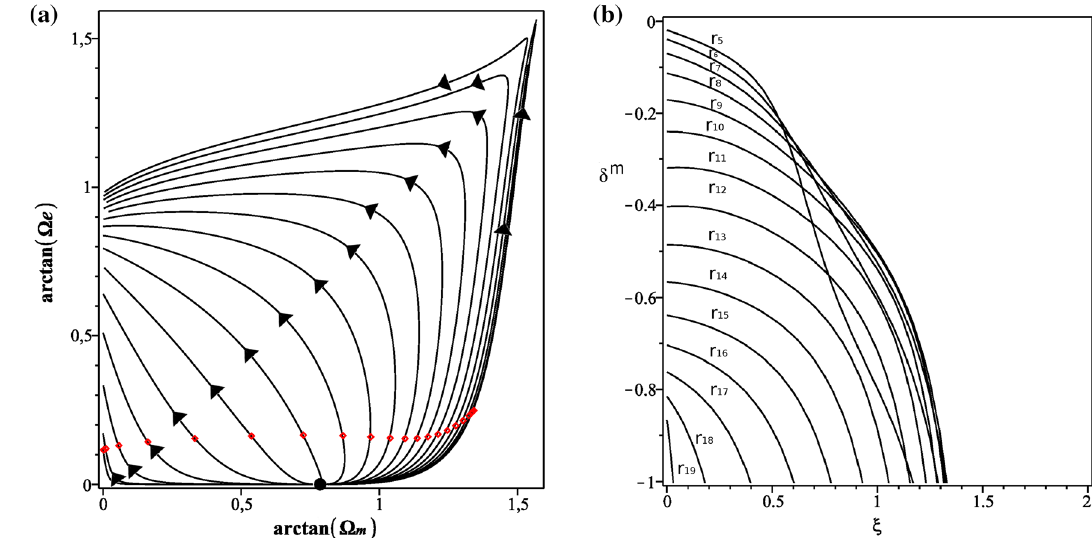
Fig. 7 a Homogeneous projection of the trajectories of the system (20a–20e) for the different shells of the configuration with initial con- ditionsgivenby(31)and w = − 1 . 0, α = − 0 . 1.Thegreylinerepresents